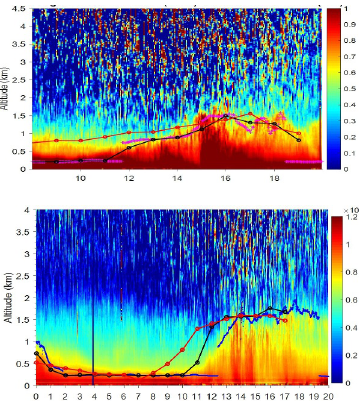
Fig 4. PBLH spatial distribution at 19:00 UTC on Aug. 29 by WRF-Chem model; ceilometer observation at Eatons Neck (coastal site) on Aug. 28 (top) and 29 (bottom). (red line: model; black: obs.; pink: 2-min ave for the obs.